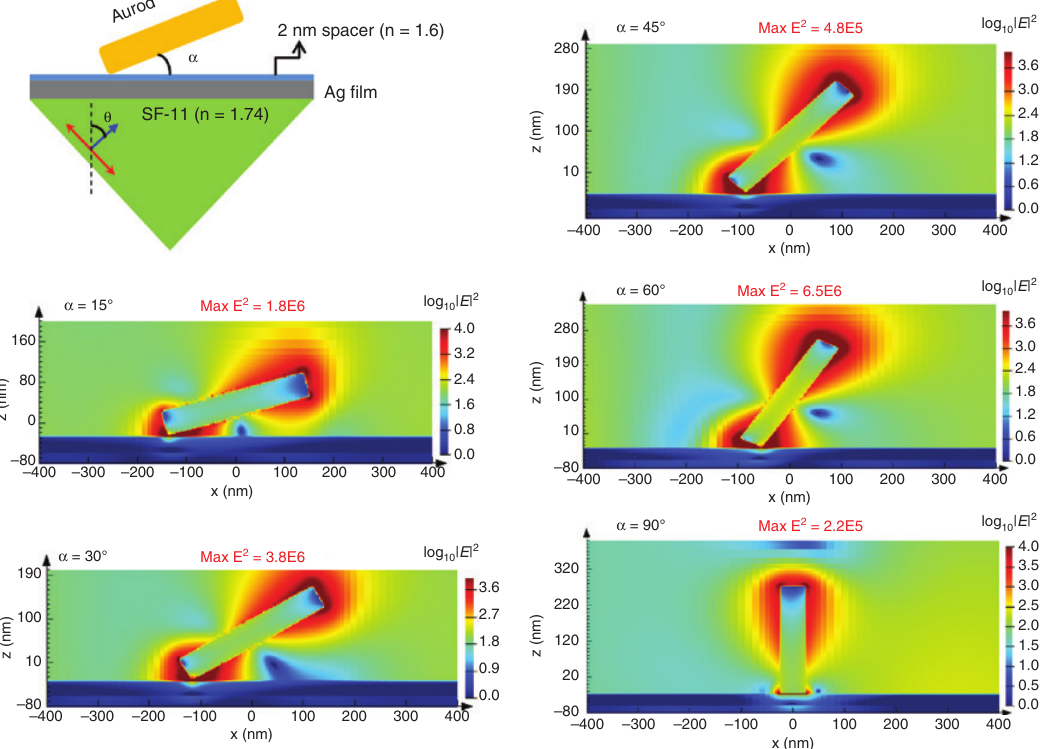
Figure 20: FDTD simulation results of the field intensity distribution around a gold nanorod of 50 nm diameter and 300 nm long on top of silver film on SF11 prism for the ESP-LSP coupling in the near infrared (1500 nm wavelength) at different orientations of the nanorod. The angle inside the prism is 50.764 ° and dielectric spacer layer is 2 nm of n = 1.6 between the NP nanorods and the 32-nm-thick Ag film. The light is incident from the left